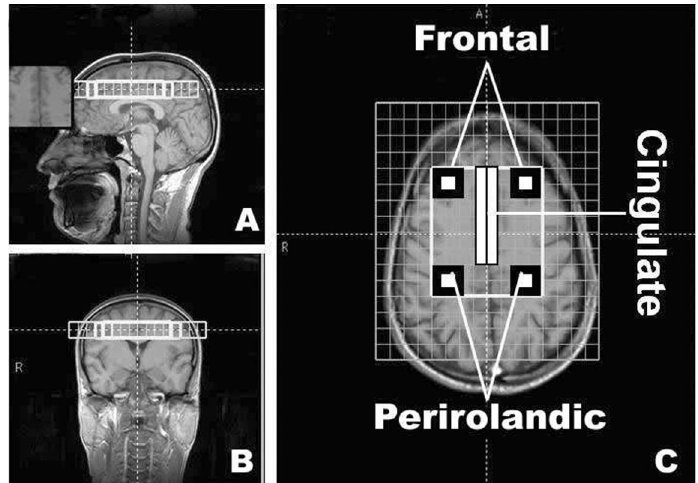
Figure 1. Midsaggital (A), axial (B) and coronal (C) magnetic resonance spectroscopy images of a normal comparison subject with the representa- tive voxel box